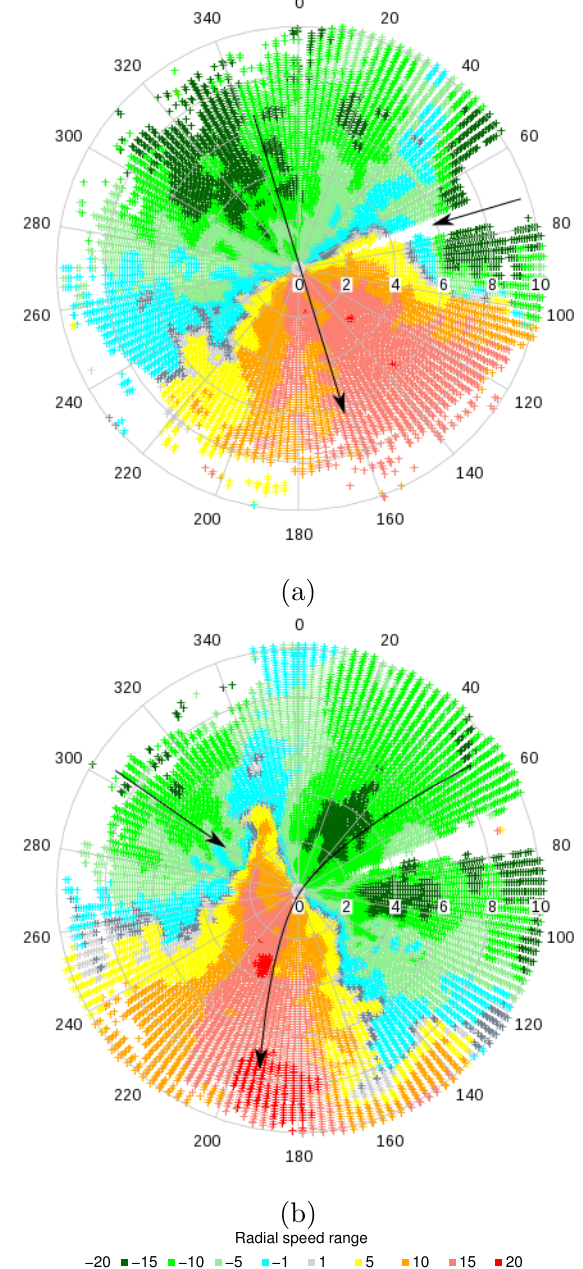
Fig. 5. 4 ◦ elevation wind lidar scans at 12:45 (a) and 13:00UTC on 24 March. Warm colors mean a radial wind (ms − 1 ) going away from the lidar contrary to cold colors which represent a wind com- ing to the lidar. Arrows indicate a wind direction